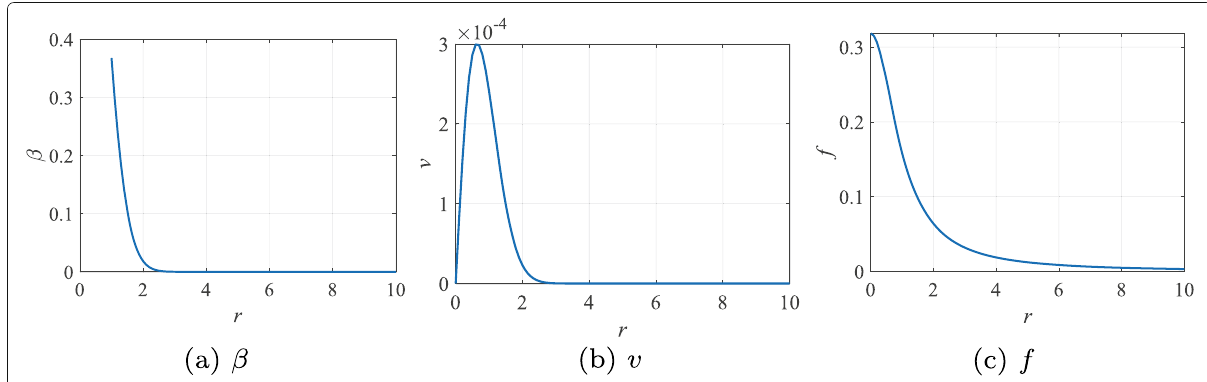
Fig. 1 The relationship between the three different attracting factors and distance r . For Fig. 1a, β 0 = 1, γ = 1; for Fig. 1b, β 0 = 1, γ = 1, t max = 1000